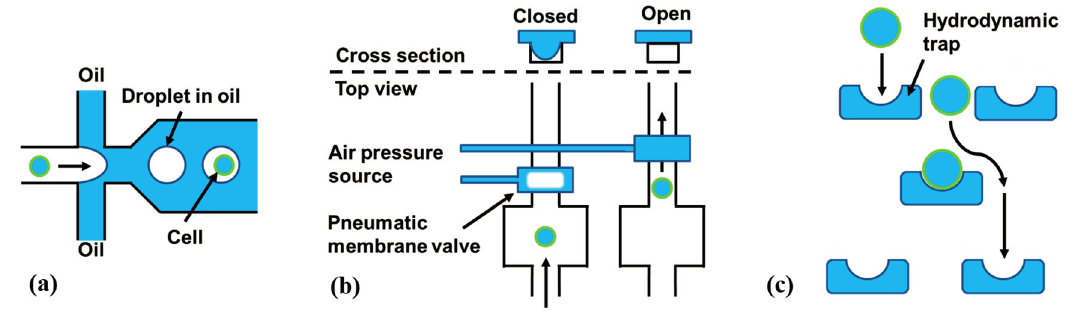
Figure 5. Schematic overview of different microfluidic methods for single-cell isolation. ( a ) An aqueous stream of cells is broken up into individual droplets-in-oil containing random distribution of cells; ( b ) Pneumatic membrane valves use air pressure to close a microfluidic channel by membrane deflection. This stops the flow and can trap a cell; and ( c ) Hydrodynamic traps are passive elements that only fit single cells and hold them at one